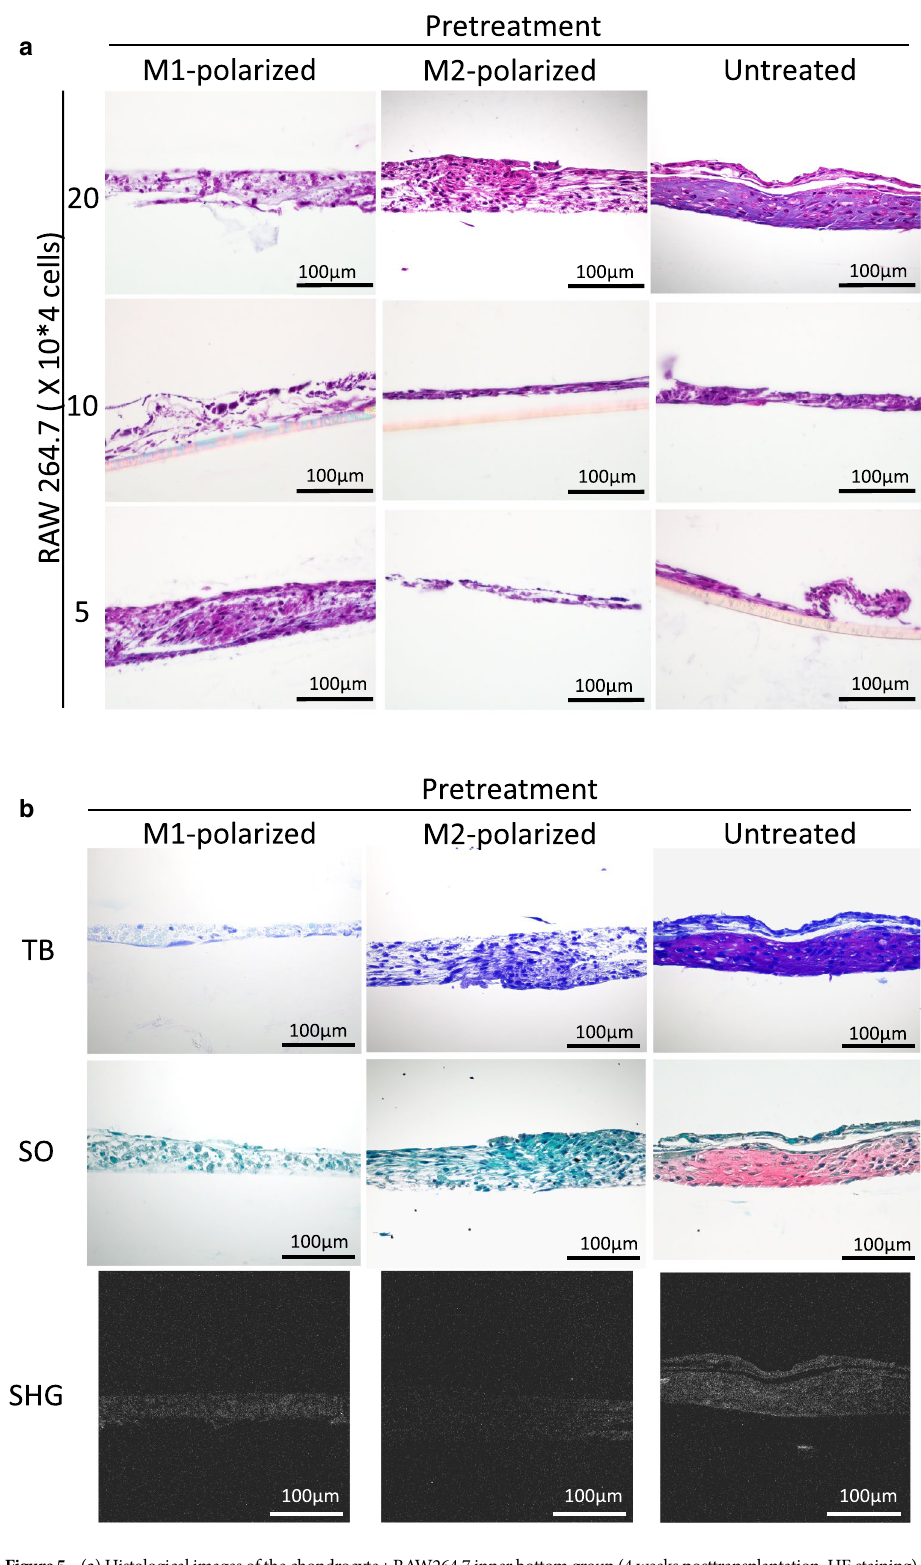
Figure 5. ( a ) Histological images of the chondrocyte + RAW264.7 inner bottom group (4 weeks posttransplantation, HE staining). Cartilage-like tissue was observed in the group that was transplanted with 20 × 10 4 untreated RAW264.7 cells. ( b ) Cartilage matrix staining and SHG images of chondrocytes + RAW264.7 cells in the inner bottom group (20 × 10 4 RAW264.7 cells, 4 weeks posttransplantation, TB: toluidine blue staining, SO: safranin-O staining). Cartilage matrix was observed in the untreated group. ( c – e ) The thickness, area and percentage of the positive area in the binarized image of the chondrocyte + RAW264.7 inner bottom group (20 × 10 4 RAW264.7 cells, 4 weeks posttransplantation). The data are shown as the means ± S.D. n = 3. ( c ) Comparison of the thickness. ( d ) Comparison of the area. ( e ) Comparison of the percentage of the binarized positive area. *p = 0.0477, **p = 0.0264. ( f ) Binarized images of the chondrocyte + RAW264.7 inner bottom group (4 weeks posttransplantation, HE